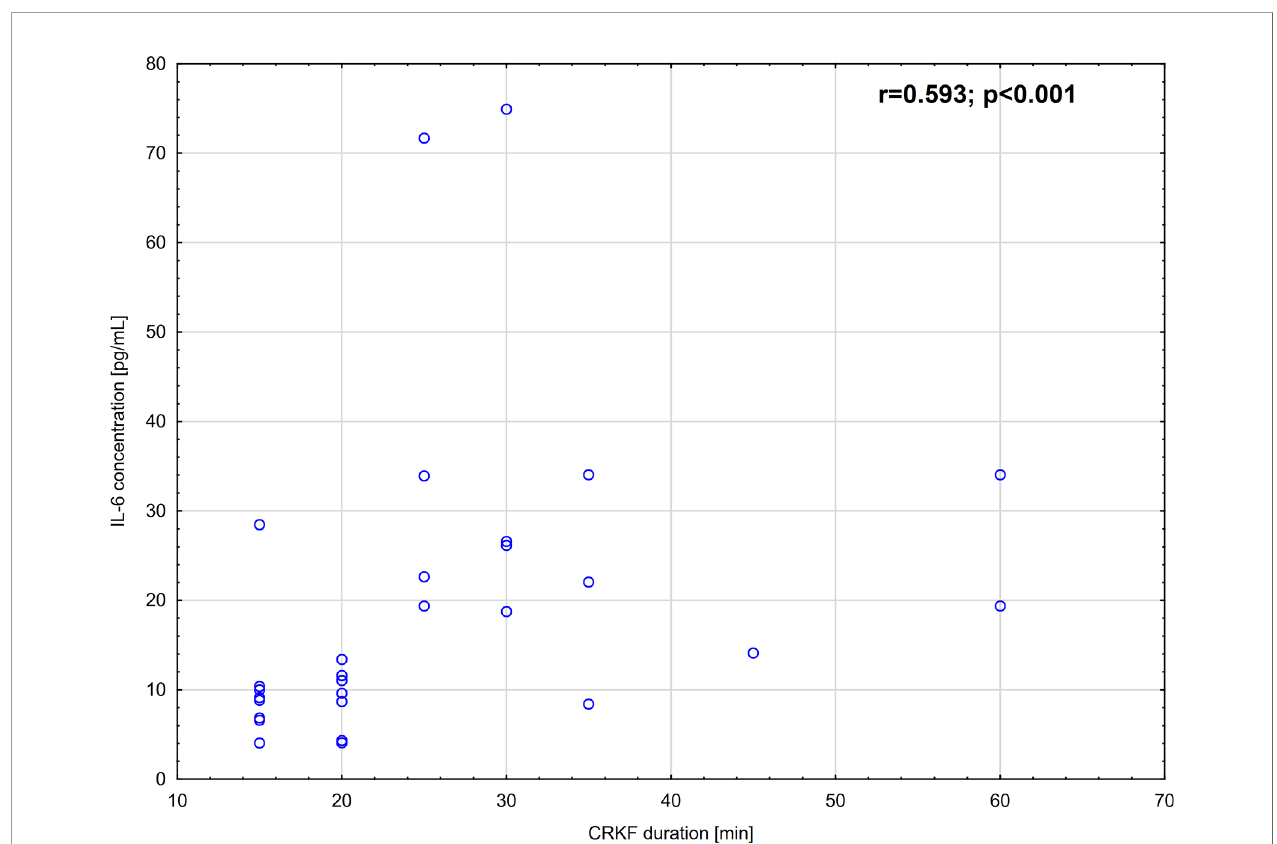
FIGURE 1 | Correlation between plasma IL-6 concentration and CRKF